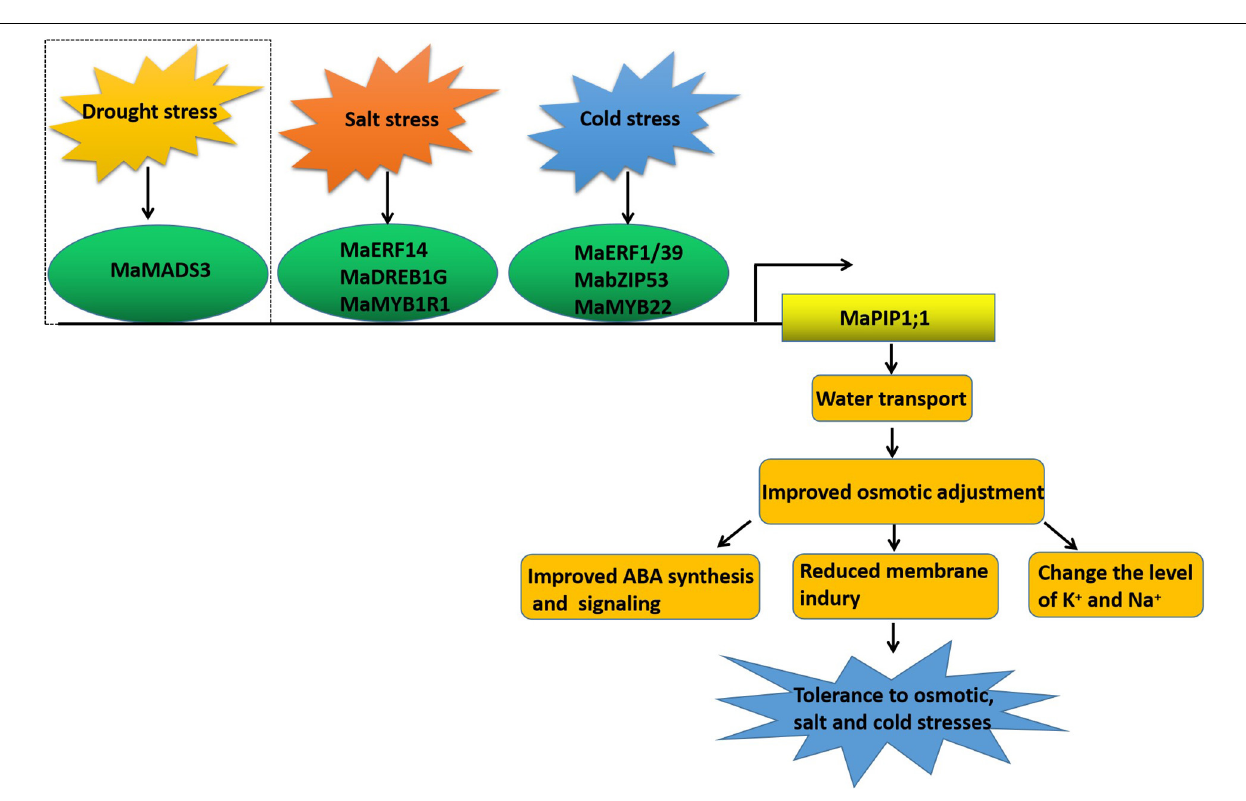
FIGURE 12 | MaPIP1;1 combines with transcription factors under different abiotic conditions to improve the drought, salt, and low-temperature tolerance of transgenic bananas. The dotted line indicates the previous